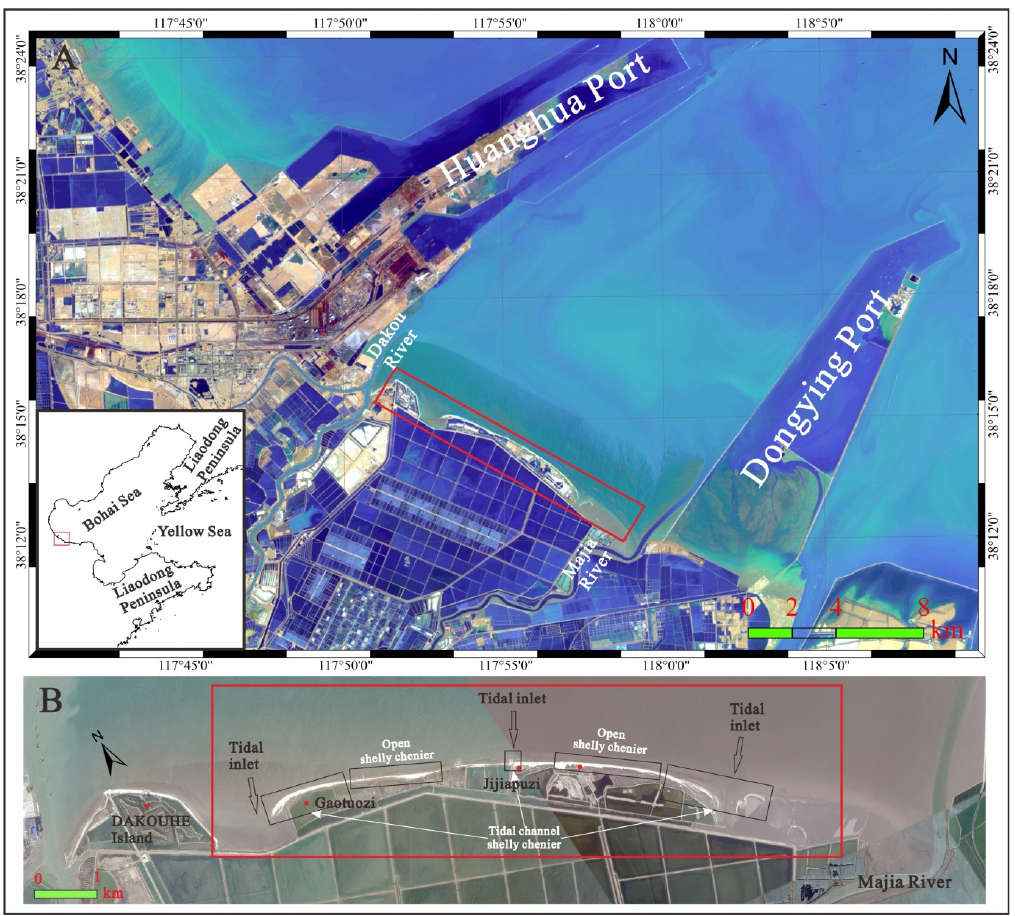
Figure 2. (A) The geographical location of the study area, ( B ) The classification of shelly cheniers, Tidal channel shelly chenier: located near the tidal inlet and significantly affected by tidal current; Open shelly chenier: significantly affected by direct scouring and silting of waves.